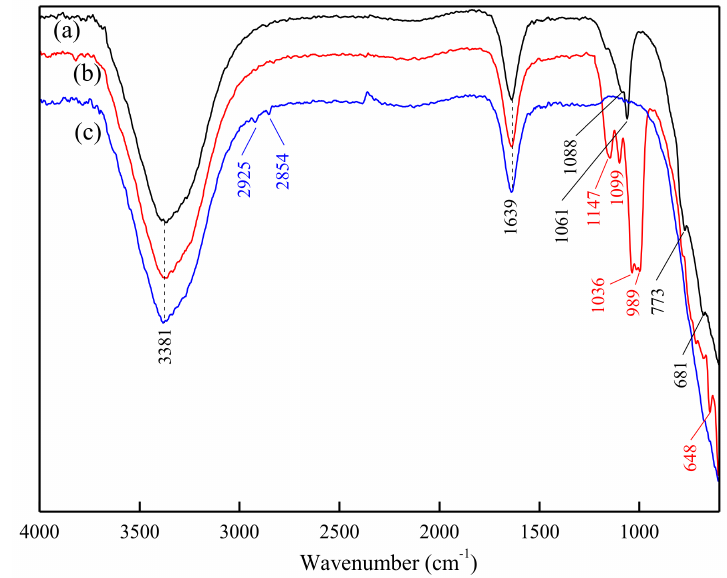
Figure 6. Attenuated total reflection flourier transformed infrared spectroscopy (ATR-FTIR) spectra of quartz (a), feldspar (b) and DDA (c) at pH 2 in water